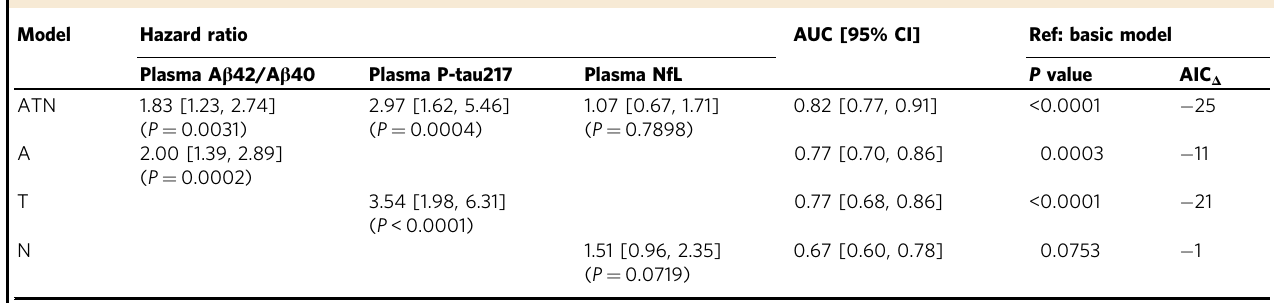
Table 3 Association between plasma biomarkers and conversion to AD